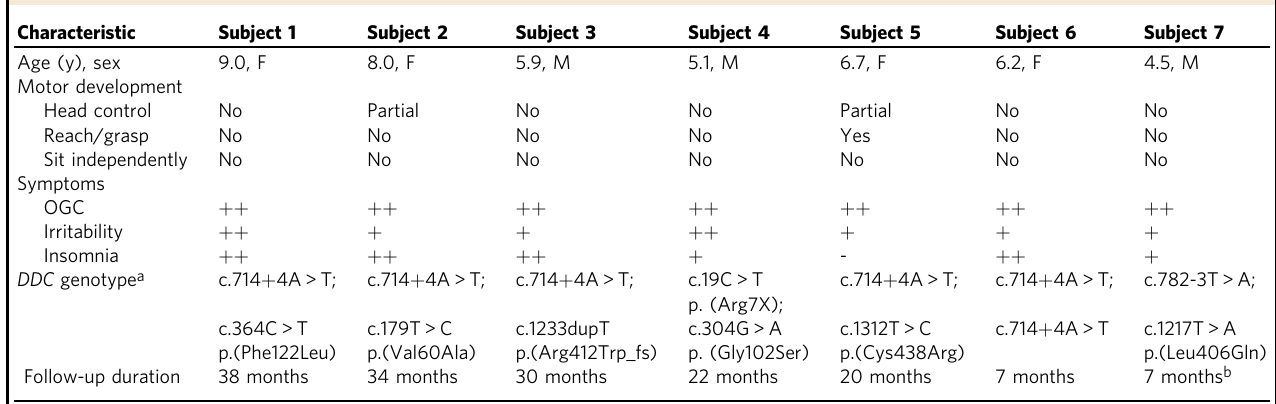
Table 1 Baseline demographic and clinical characteristics of the 7